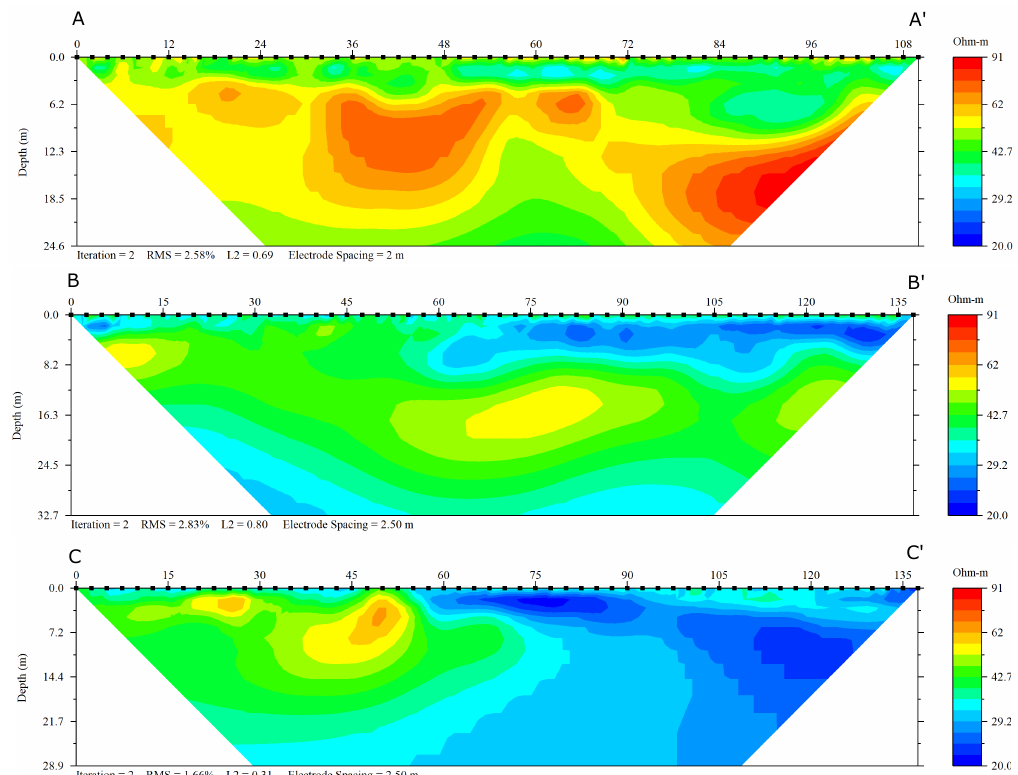
Figure 5. Inverted electrical resistivity tomography profiles in lower Scotts Creek. All data were collected with a SuperSt- ingR8 electrical resistivity meter and processed with EarthImager2D software. Each profile consisted of 56 electrodes spaced at 2 m in A – A (cid:48) and 2.5 m in B – B (cid:48) and C – C (cid:48) . Profiles A – A (cid:48) and B – B (cid:48) were collected with a dipole-dipole array geometry and profile C – C (cid:48) with a Schlumberger array geometry. The inverted data for all three profiles are plotted on a common color scale. Inversion iteration number, RMS misfit, and L2 misfit are shown beneath each panel. Dimensions of the figure panels vary, but are plotted without vertical